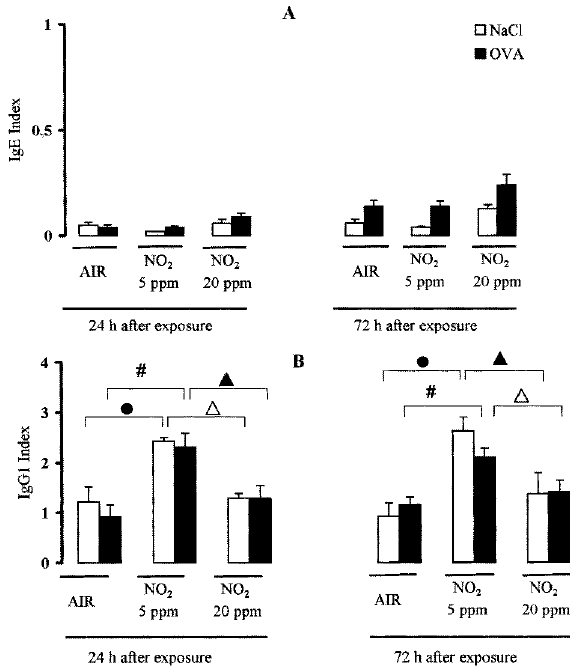
FIG. 5. Specific anti-OVA IgE and IgG1 titers in the serum after exposures to NO 2 . At day 14, immunized mice were treated as in Fig. 2 (Saline ( h ) or OVA ( j )). Specific antibodies were evaluated in the serum by ELISA. (A) IgE and (B) IgG1. Data are expressed as the mean ± SEM. # p £ 0.05, OVA-air group compared with the NO 2 -OVA group (5 or 20ppm); d p £ 0.05, saline-air group compared with the NO 2 - saline group (5 or 20ppm); m p £ 0.05, 5ppm NO 2 -OVA group compared with the 20ppm NO 2 -OVA group; n p £ 0.05, 5ppm NO 2 -saline group compared with the 20ppm NO 2 -saline